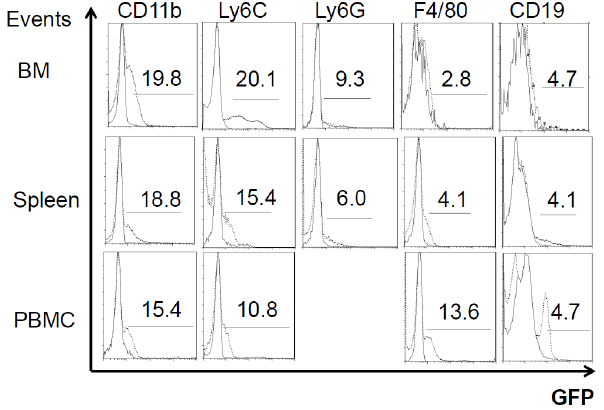
Figure 3. Fluorescent cells in BM, spleen and PBMC subpop- ulations. Mice were infected with B. pseudomallei- GFP. The solid lines represent controls (no infection). The dotted lines represent the fluorescent cells in each phagocytic (CD11b + , F4/80 + , Ly6C + and Ly6G + ) and lymphoid (CD3 + , CD4 + , CD8 + , CD19 + and NK1.1 + ) population on day 10 post-infection. If the GFP was below 1%, the data are not shown.